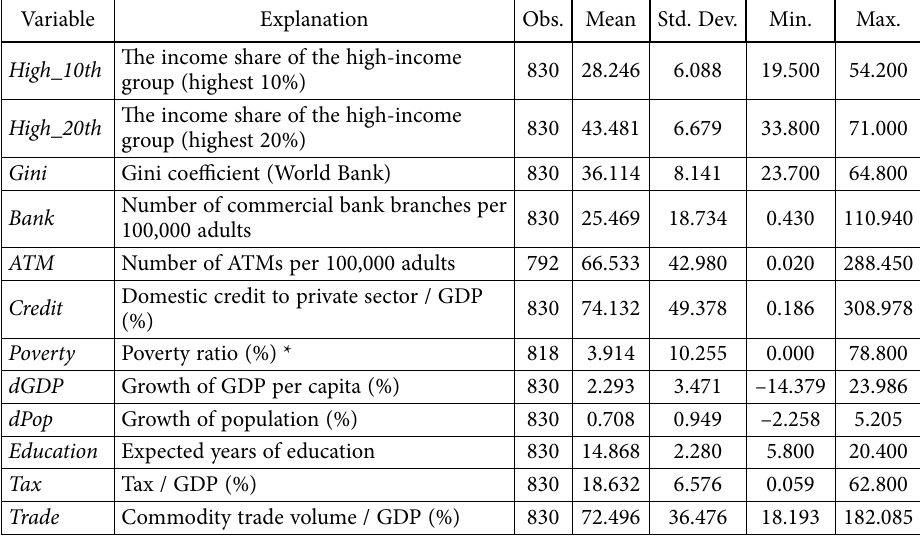
Table 1. Descriptive Statistics (2004–2018)